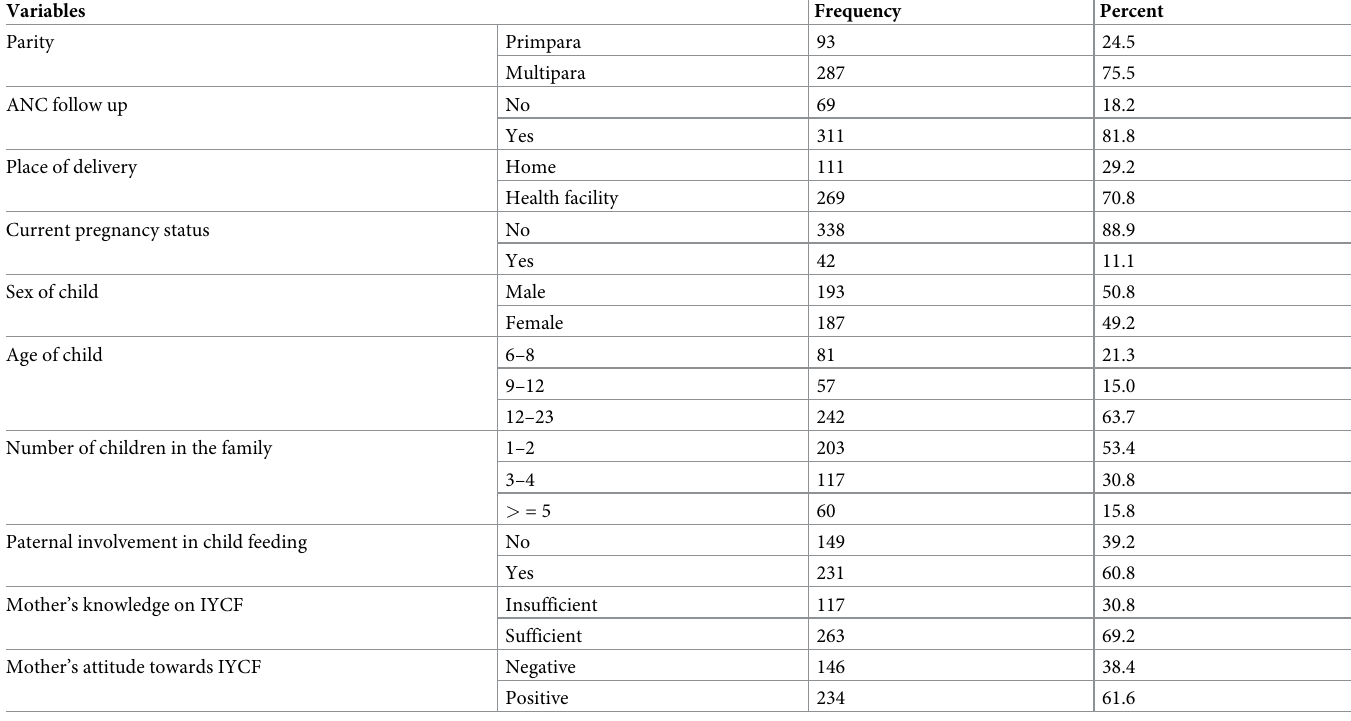
ANC, Antenatal care; IYCF, infant and young child feeding.